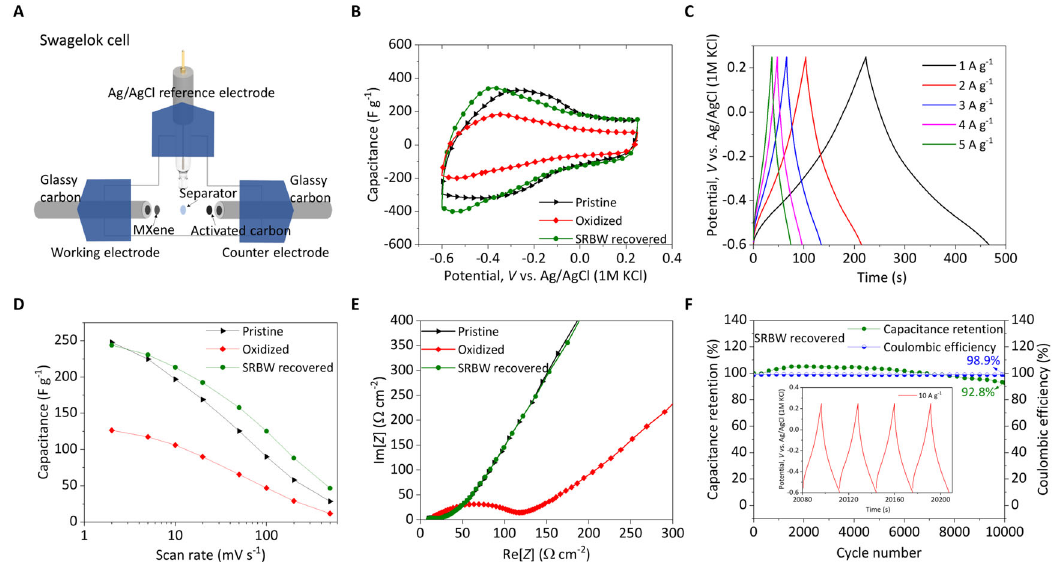
D Gravimetric capacitance of the pristine and SRBW-restored Ti 3 C 2 T z MXene fi lm electrodes for different scan rates. E Nyquist plots for the pristine, control (oxi- dized) and SRBW-restored Ti 3 C 2 T z MXene electrodes at open circuit potentials; Re[ Z ] and Im[ Z ] denote the real and imaginary impedances of the system. F Life cycleperformanceoftheSRBW-restoredTi 3 C 2 T z MXene fi lmat500mVs − 1 showing 92.8% capacity retention and 98.9% Coulombic ef fi ciency; the inset shows results from the GCPL stability test performed at 10 A g − 1 over 10,000 cycles. In all of the cases, the SRBW power is held constant at 25